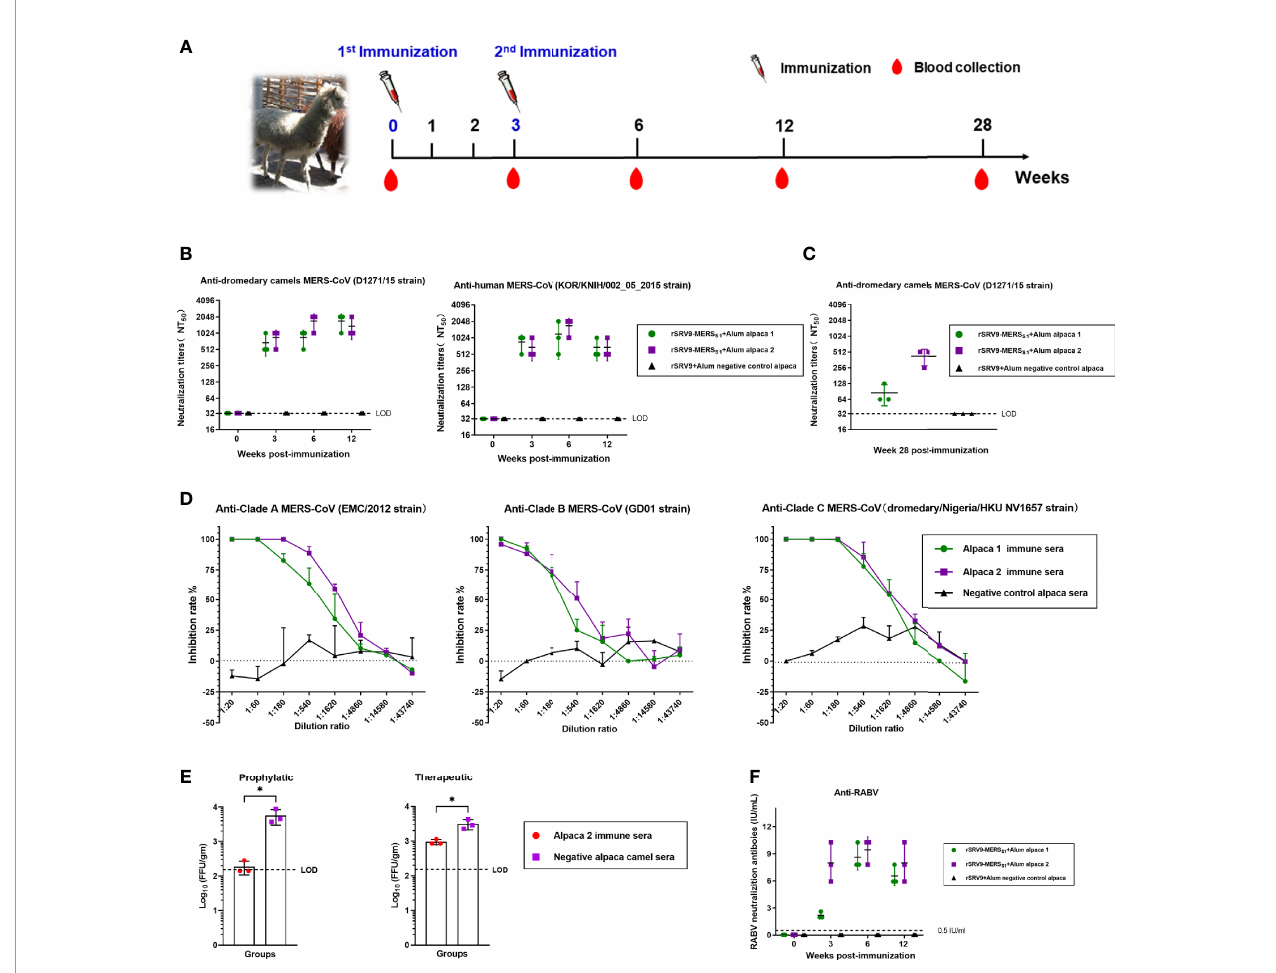
FIGURE 6 | Humoral immune responses elicited by the inactivated rabies virus-vectored MERS-CoV vaccine in alpacas. (A) The schematic of the alpaca immunization experiment. Three alpacas received 3 ml of inactivated recombinant rabies virus-vectored MERS-CoV vaccine (n = 2) or phosphate-buffered saline (PBS) (n = 1) by multiple sites of subcutaneous (s.c.) injection in the neck two times at 3-week intervals. Sera of alpacas from each group were harvested before the fi rst immunization and collected at 3, 6, and 12 weeks after the fi rst immunization. (B) Sera cross-neutralizing activity against representative human and camel MERS-CoV strains (human MERS-CoV KOR/HIN strain and dromedary camel MERS-CoV D1271 strain) were evaluated by a pseudovirus-based neutralization assay. (C) Sera MERS-CoV-speci fi c neutralizing antibodies measured 28 weeks after the fi rst immunization by a pseudovirus-based neutralization assay. (D) The cross-neutralizing activity against live viruses among the known MERS-CoV clade A (EMC/2012 strain), clade B (ChinaGD01 strain), and clade C (dromedary/Nigeria/ HKU NV1657 strain) were measured by focus reduction neutralizing assay. (E) Prophylactic and therapeutic ef fi cacies of passive transfer with the rabies virus- vectored MERS-CoV vaccine alpaca immune sera collected at 6 w.p.i in MERS-CoV-infected Ad5-hDPP4-transduced mice. A total of 200 m l of alpaca immune sera collected were intravenously transferred 1 day before or after MERS-CoV (EMC/2012 strain) infection. Mice in the control group intravenously received the same dose of negative sera from healthy alpacas at the same time points. (F) Sera RABV-speci fi c neutralizing antibodies were evaluated using fl uorescent antibody virus neutralization (FAVN). Data are shown as mean ± SD. Data were obtained using GraphPad Prism version 9.0 (GraphPad software). An unpaired Student ’ s t-test (two-tailed) was used for statistical analysis, and the relevant p-values are indicated (not indicated in graph; *p <